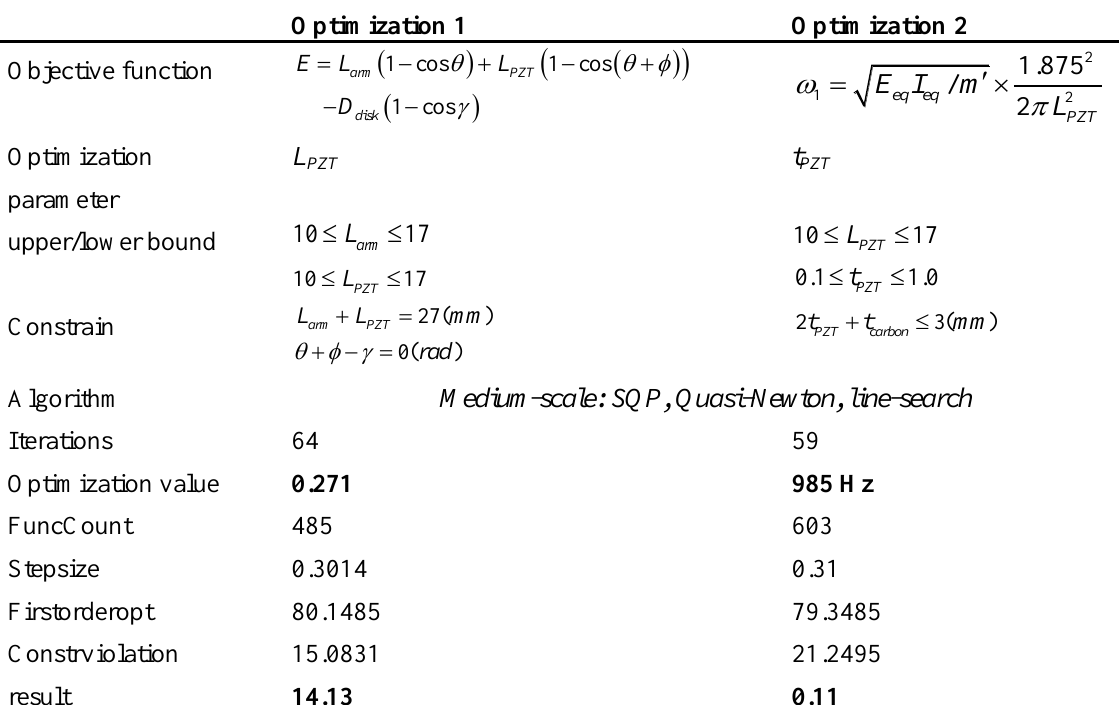
Table 1. Parametric optimization investigates the design parameters.